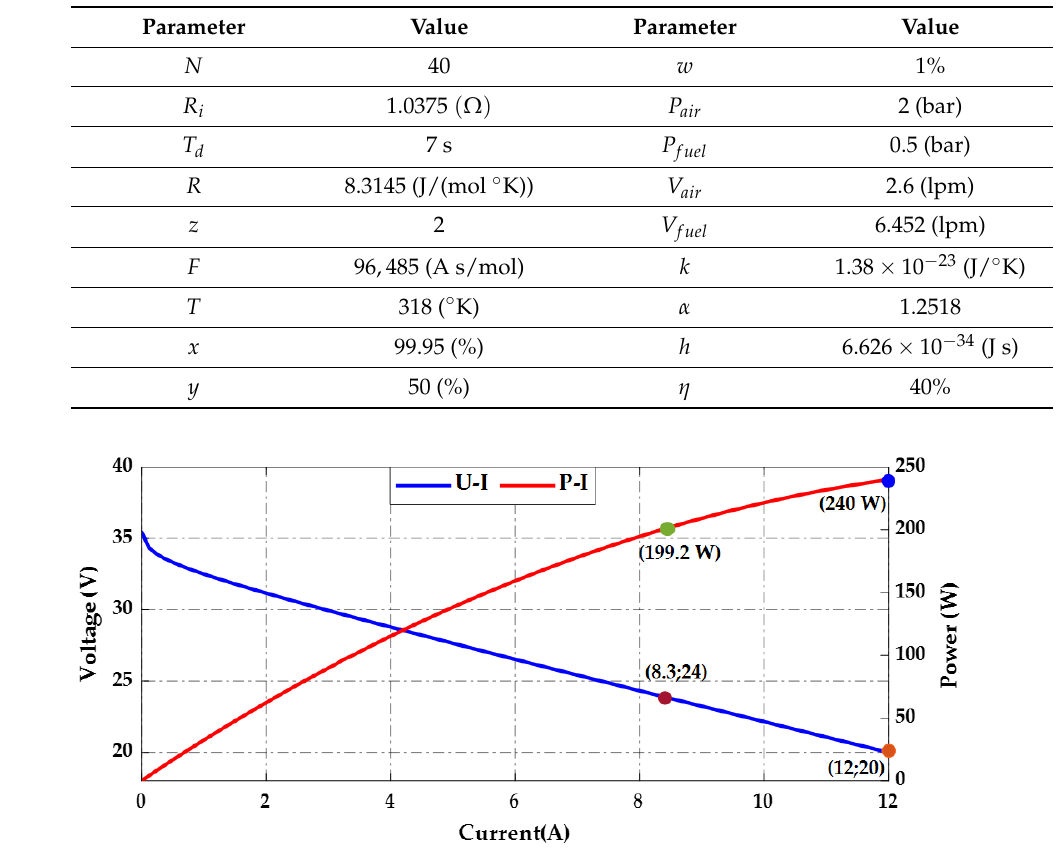
Table 1. Parameters of the PEMFC model.